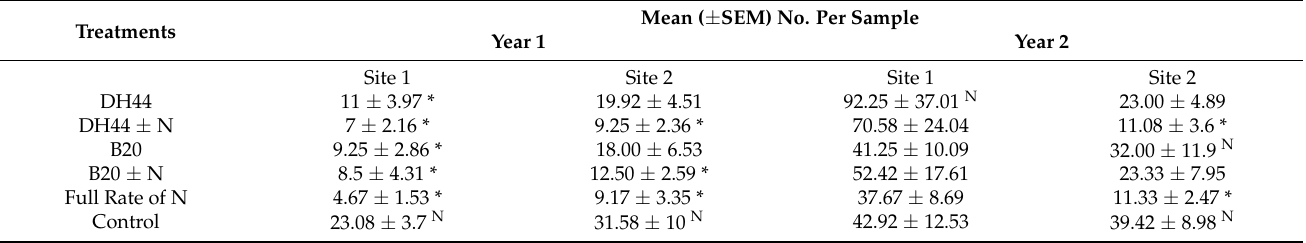
Table 4. Abundance of Collembola collected from bermudagrass forage plots treated with conven- tional fertility or